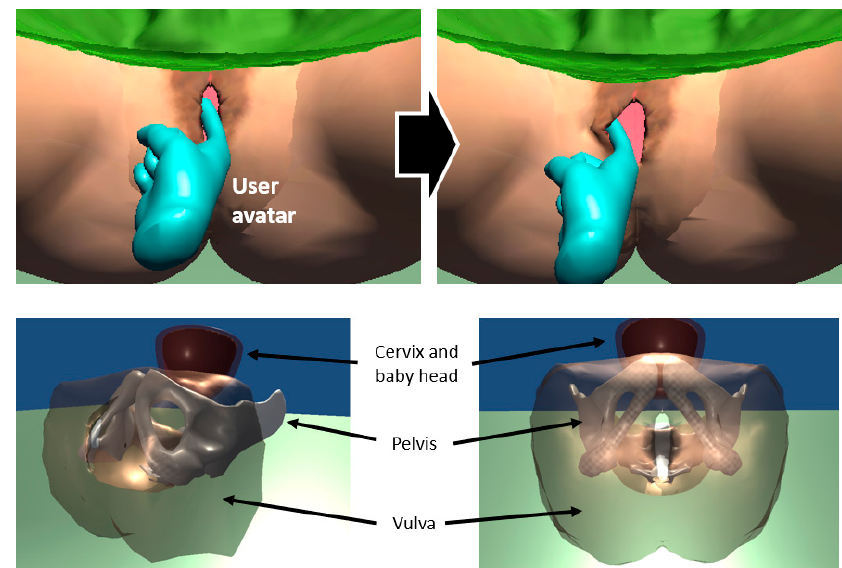
Figure 1. Interaction between a user avatar and vulva model ( top ) and internal view ( bottom ) of a pregnant woman model in AR-based training simulation of vaginal examination.